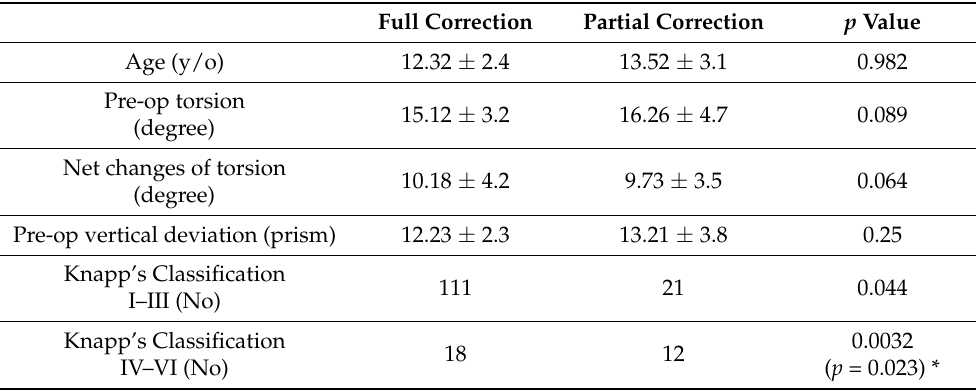
Table 3. The effective components of full correction and partial